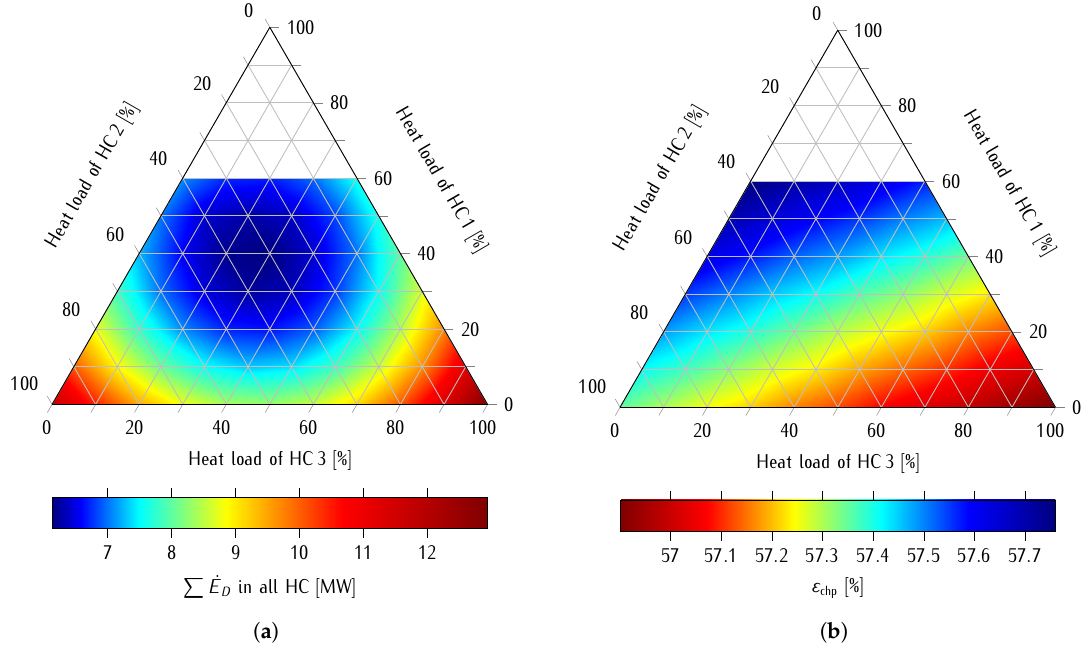
Figure 8. Sensitivity analysis for different heating load distributions; ( a ) Exergy destruction rate in heating condensers; ( b ) Overall exergetic efficiency of the CCGT